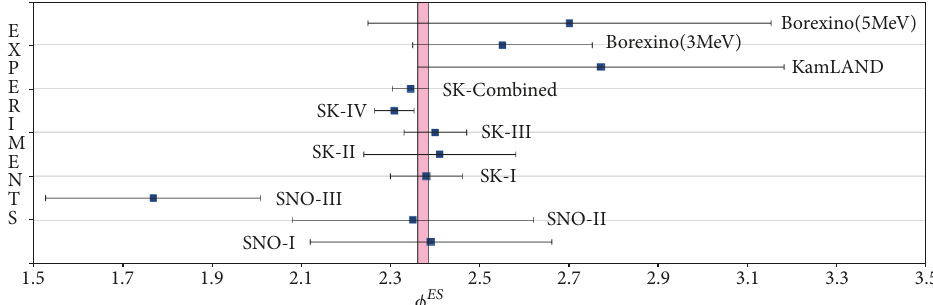
Figure 1: 𝜙 𝐸𝑆 Overlap region (shaded) from all